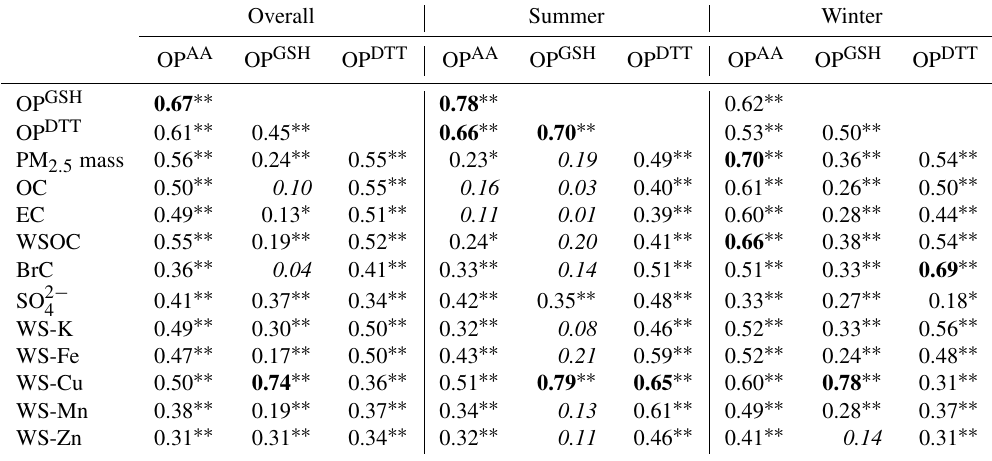
Table 1. Pearson’s r between OP and PM composition. Overall Summer Winter OP